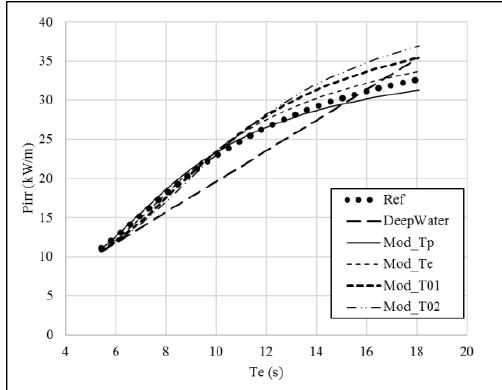
Figure 14. Modifications of the wave energy assessments using different characteristic periods ( h = 25 m).